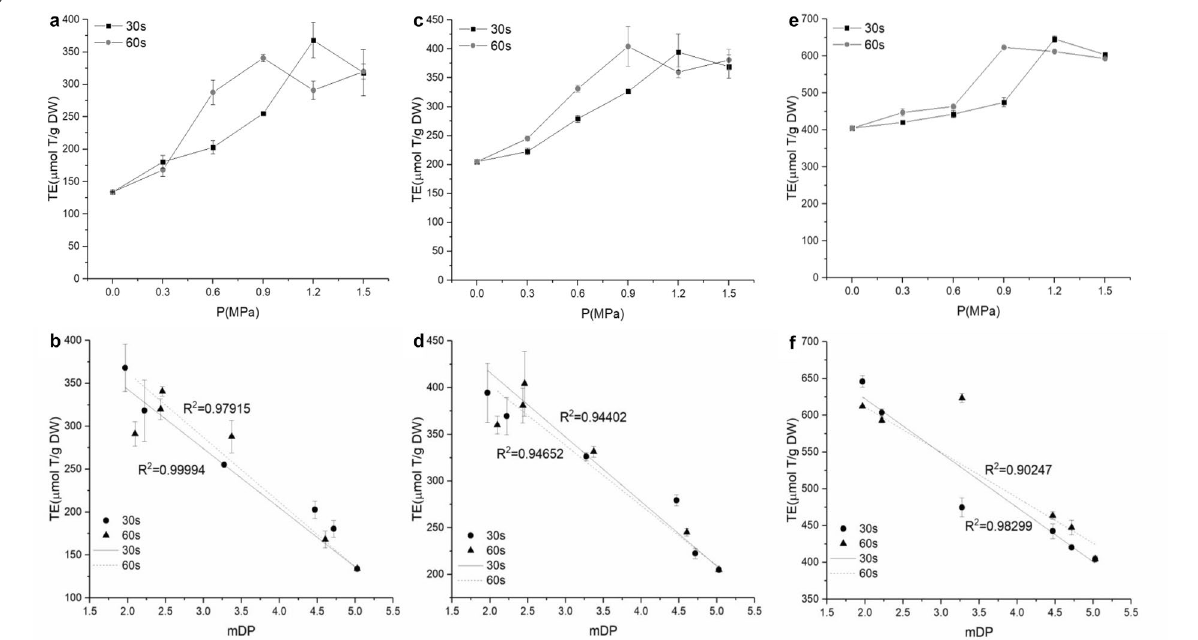
Fig. 3 Antioxidant activity of the extracts with different SE treatments using the method of a DPPH, c FRAP and e ABTS. The correlation coefficients between mDP and b DPPH assay, d FRAP assay and f ABTS